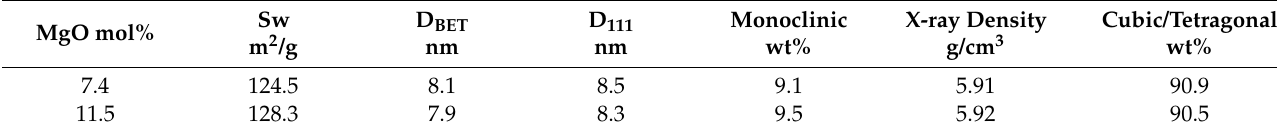
Table 1. Characteristics of MgO–ZrO 2 powders.